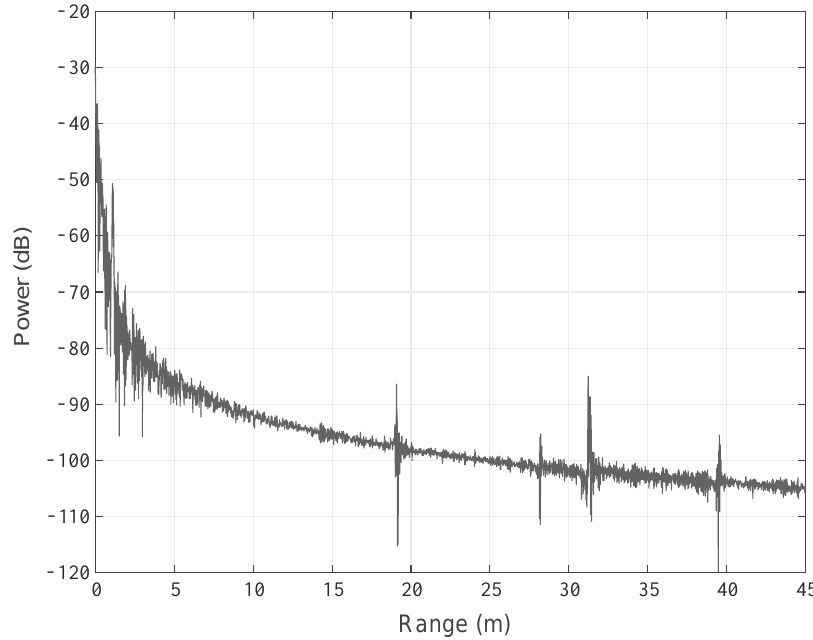
Figure 15. Measured radar diagram of scenario